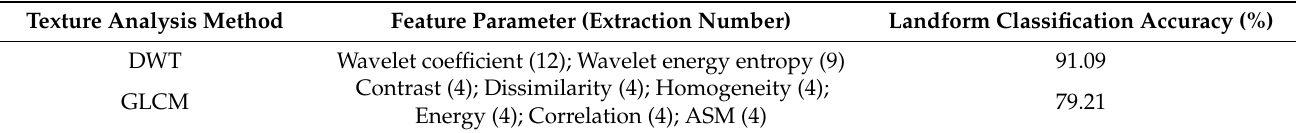
Table 3. Results of classification accuracy using the DWT and GLCM for the texture features extraction among landforms. Texture Analysis